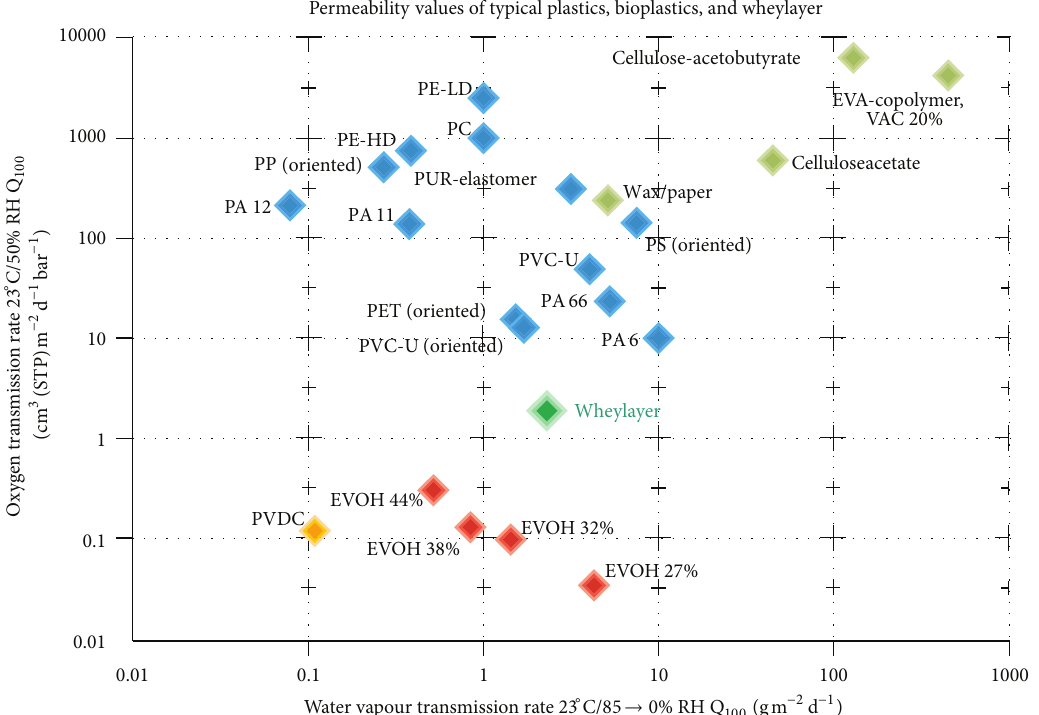
tends to wet totally the surface of the coated sample over that